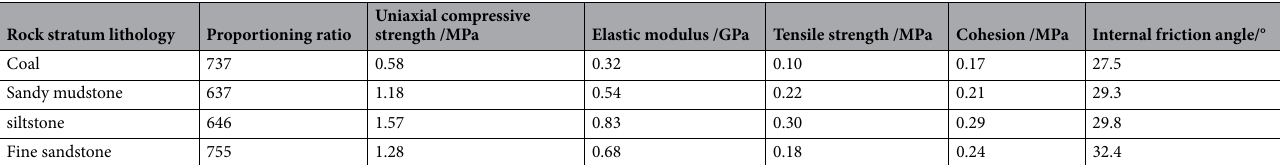
Table 1. Proportioning number and mechanical parameters of similar rock